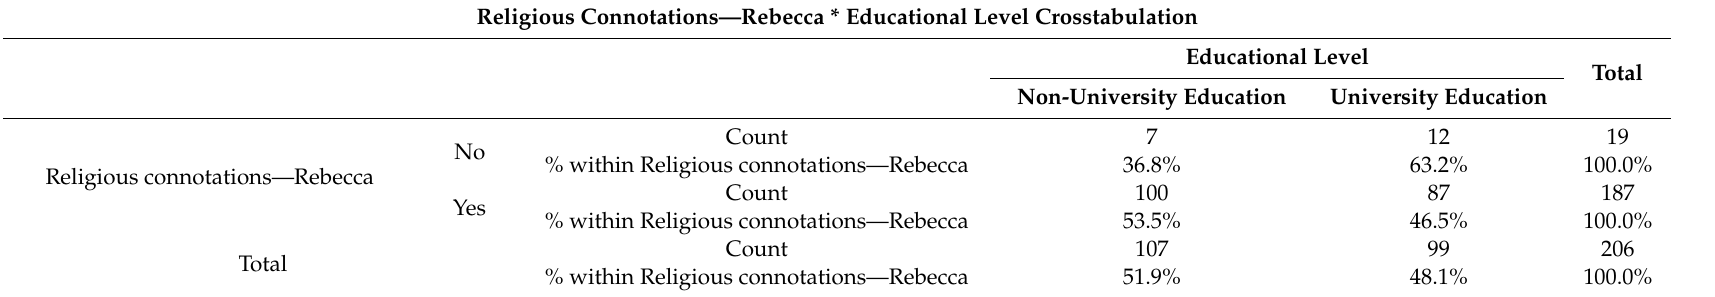
Table 9. Religious connotations in terms of educational level for the name Rebecca in the metropolitan district of